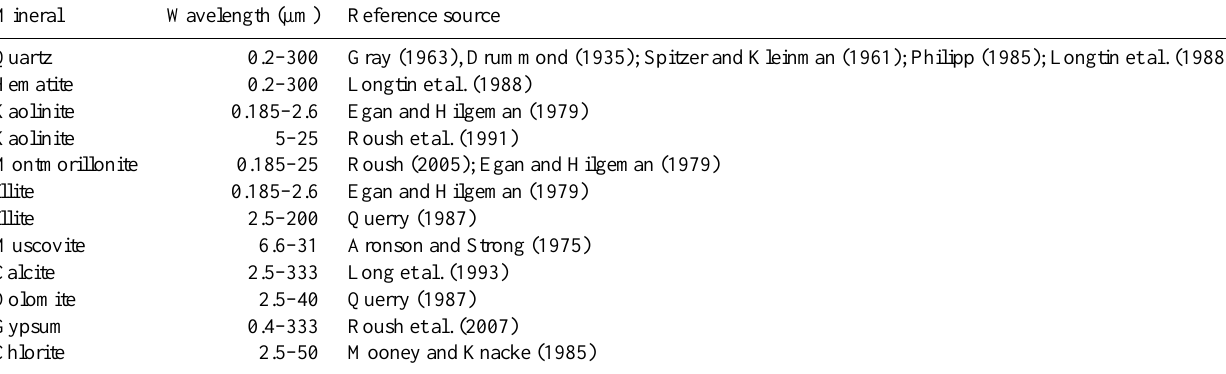
Table 1. Refractive index datasets of common dust minerals